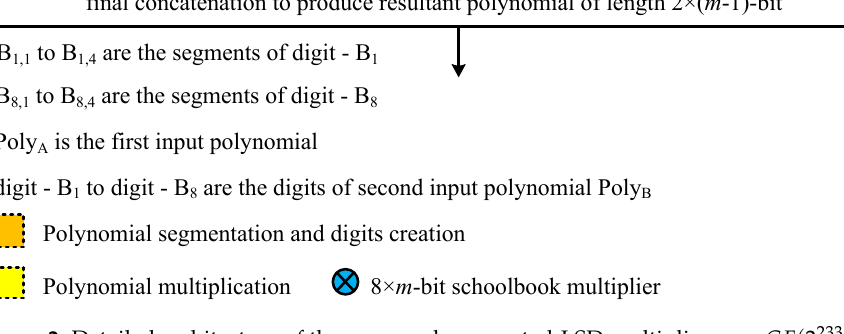
Figure 2. Detailed architecture of the proposed segmented-LSD multiplier over GF ( 2 233 )